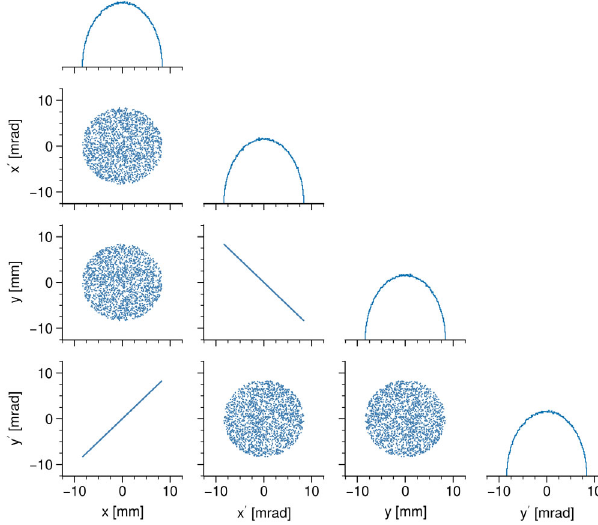
FIG. 1. The transverse phase space projections of Danilov distribution for the case when e 12 ¼ − e 21 ¼ 1 in Eq. (2). Histo- grams for each coordinate are given on the diagonal; for example, the x profile is the top left subplot.